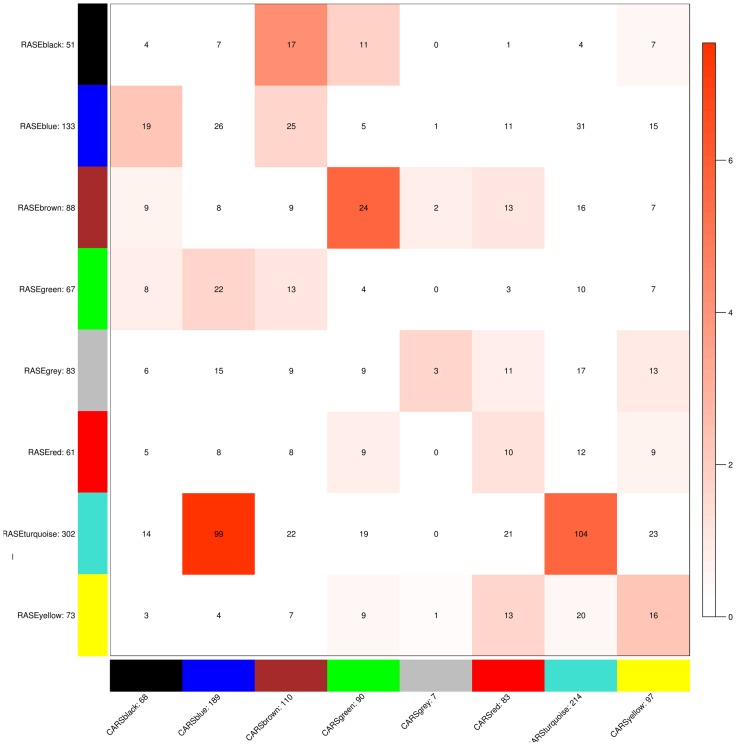
Module preservation plot representing the number of genes conserved between the modules of test network (C. roseus) and reference network (R. serpentina). Preservation significances are represented by the depth of red color.